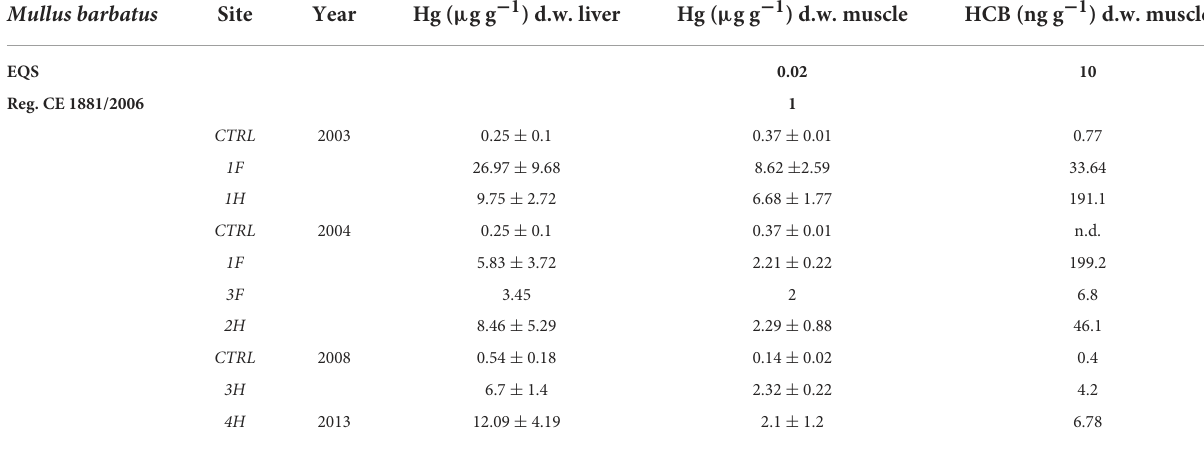
TABLE 5 Hg and HCB concentration in liver and muscle of M. barbatus . Mullus